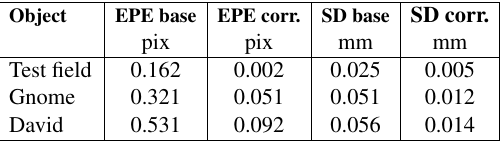
Table 2. Optical flow EPE and surface